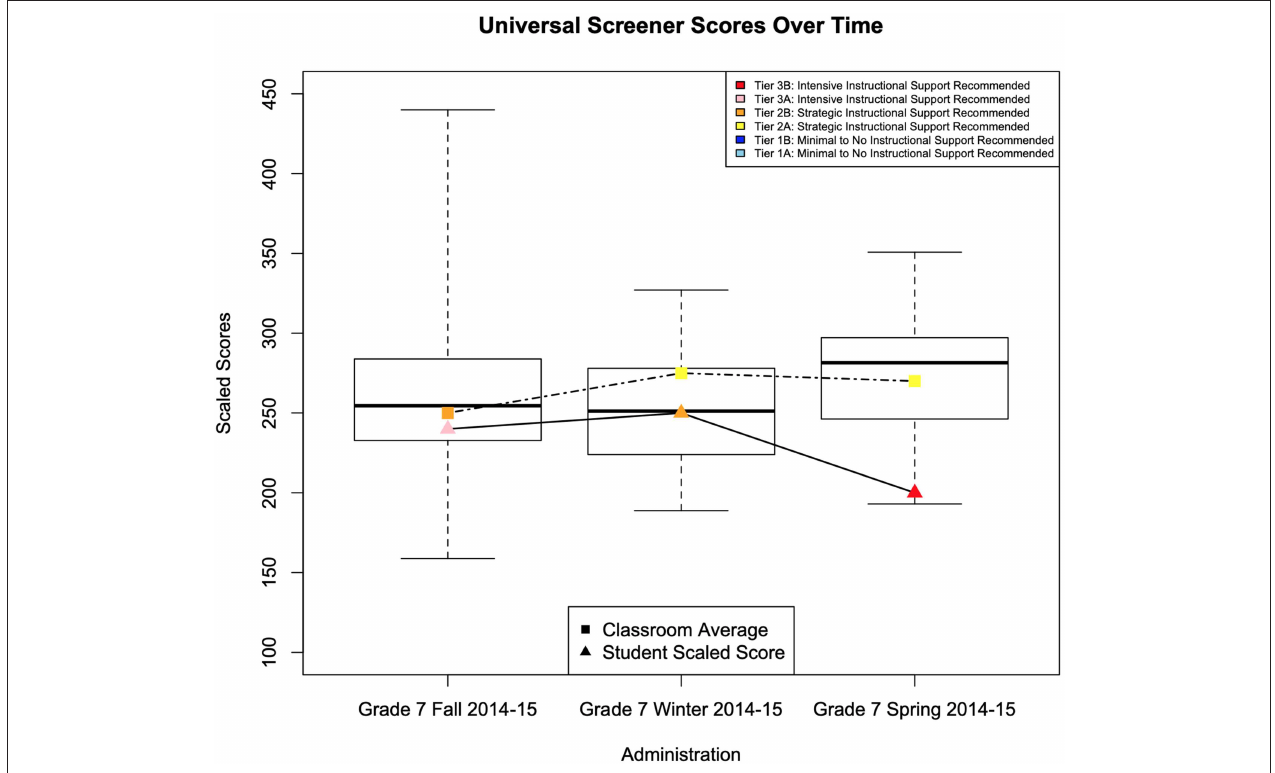
FIGURE 2 | The Comparison Over Time Report